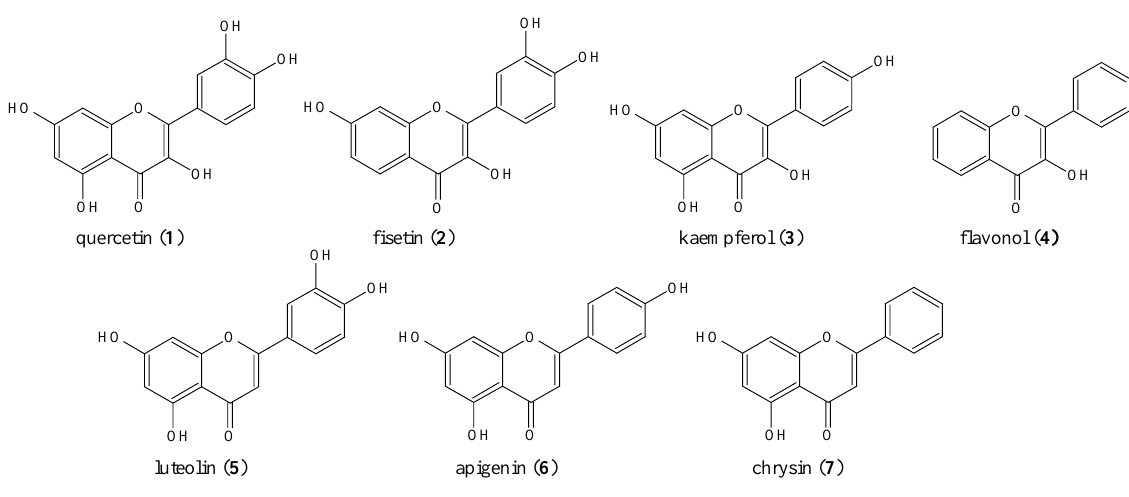
Figure 2. The structures of the standard flavonoids